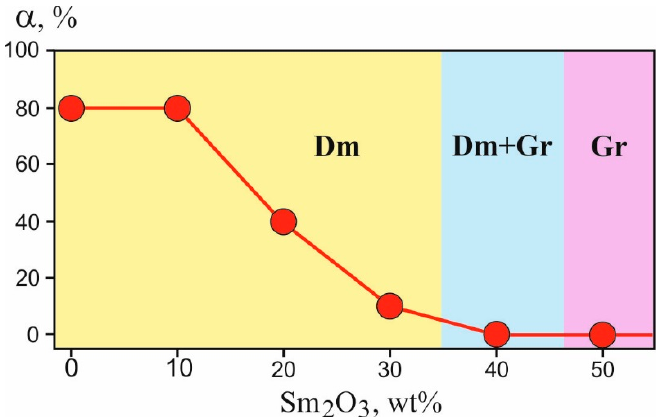
Figure 3. Degree of graphite-to-diamond conversion ( α , %) in the Mg-Sm 2 O 3 -C system as functions of Sm 2 O 3 concentration (wt %). For further explanations, see the text.